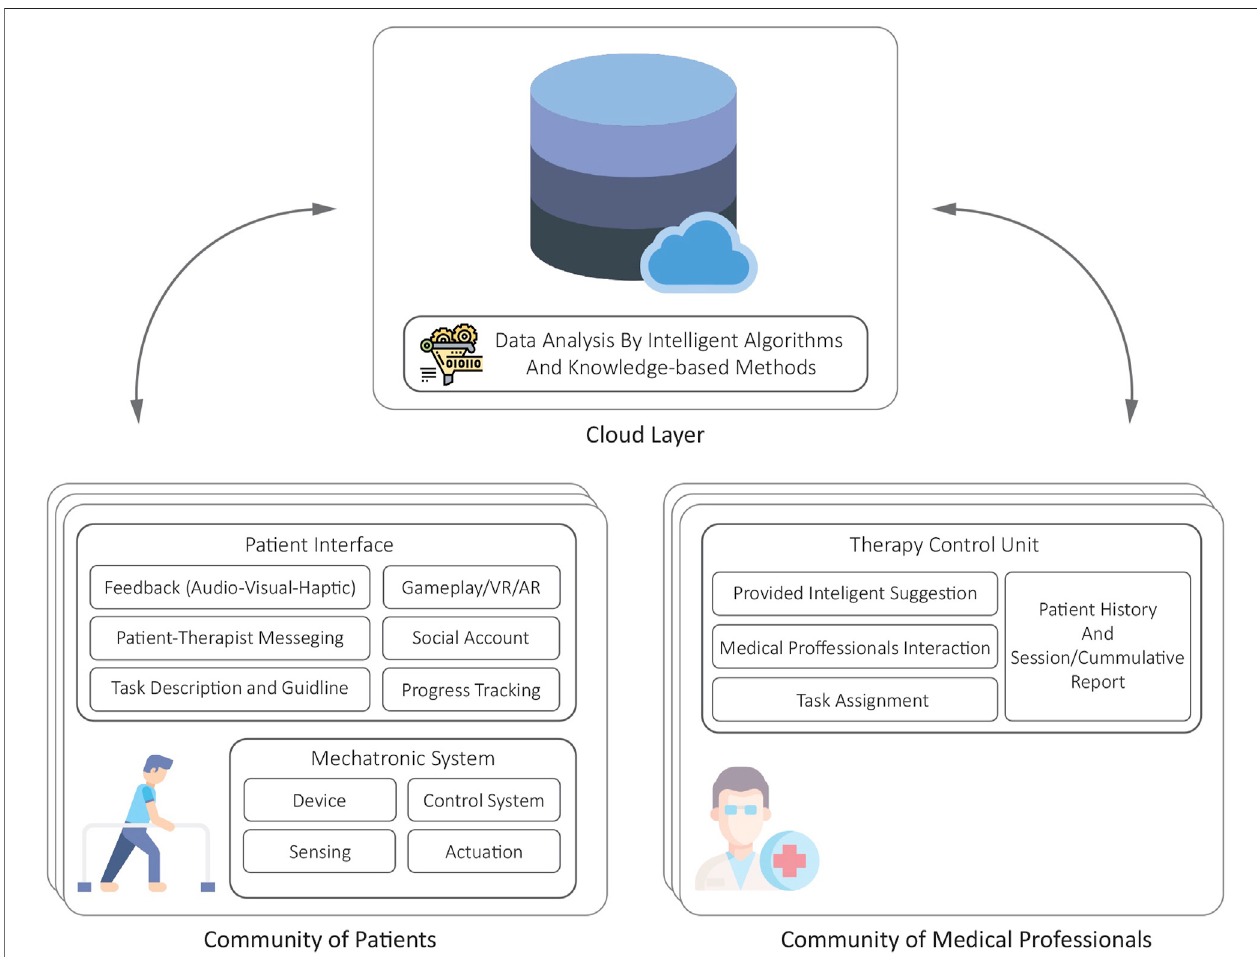
FIGURE 6 | The proposed conceptual framework for community-based home rehabilitation.